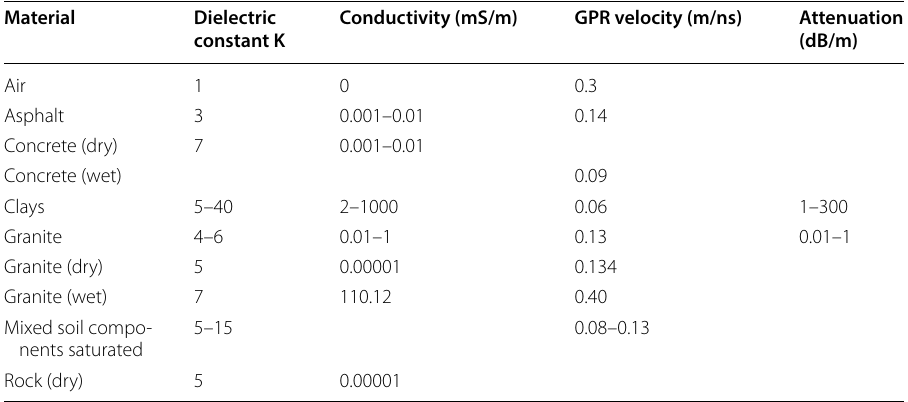
Table 1 GPR velocity table and analysis of velocity, dielectric constants, attenuation, and conductivity values for materials from various sources